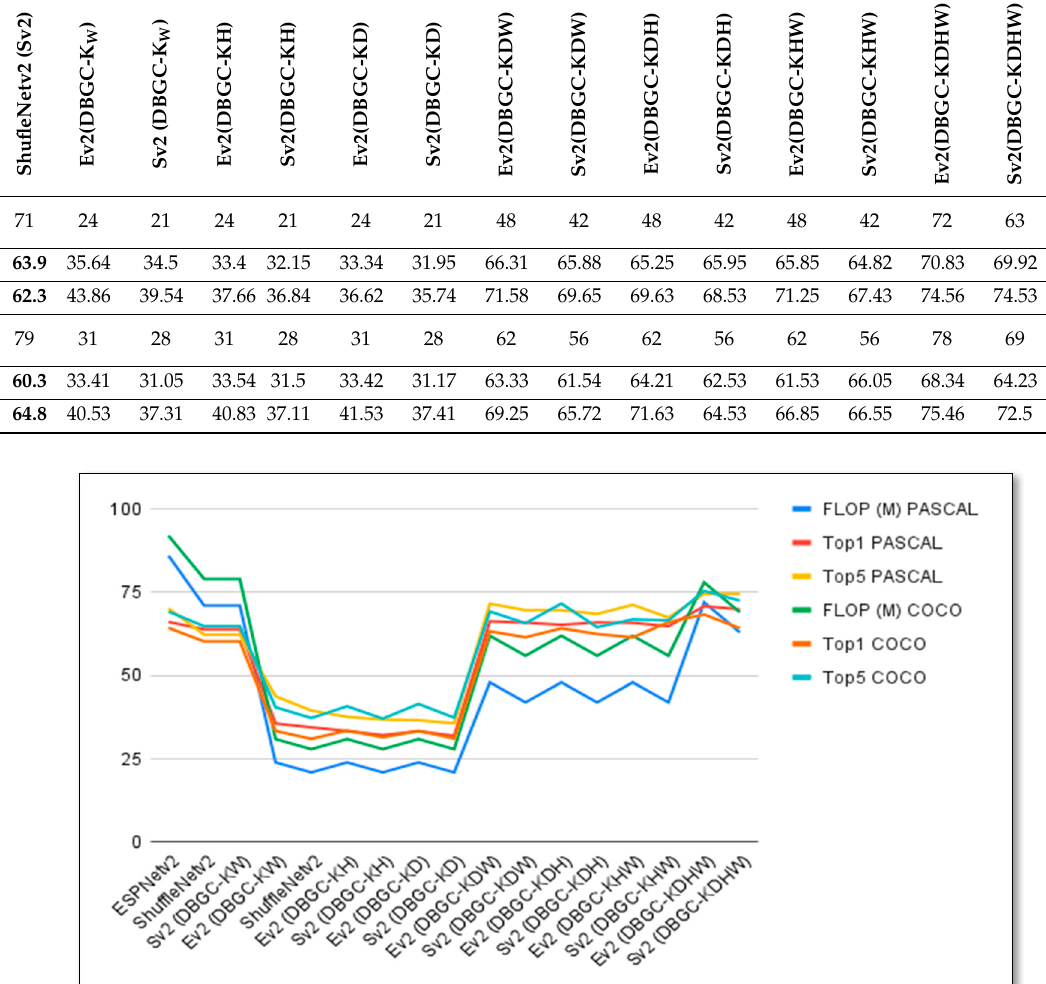
Table 10. Unoptimized, semi-optimized, and optimized kernel performances for ESPNetv2 versus ES- PNetV2 (DBGC) and ShuffleNetv2 versus ShuffleNetV2 (DBGC) for the PASCAL and COCO datasets.